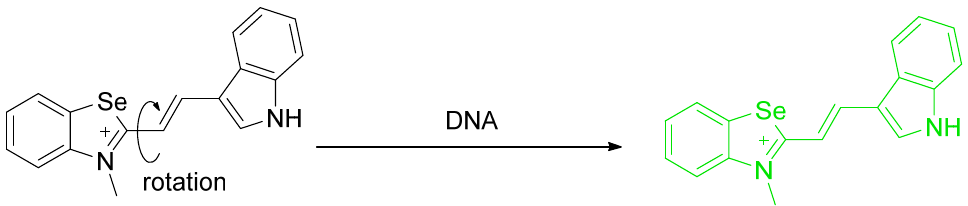
Figure 36. Structure of PA5 and a schematic of detection mechanism (chemical) reported by Gaur et al.